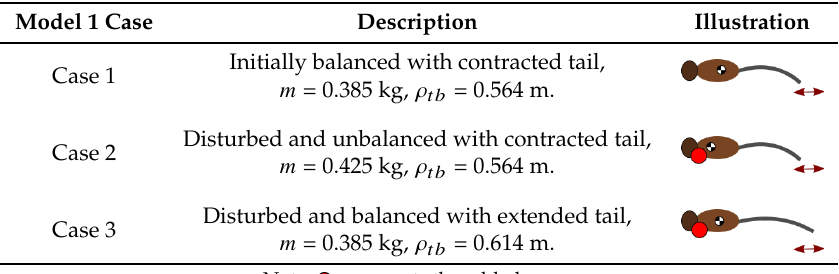
Table 5. Model 1 cases for correction of imbalance.